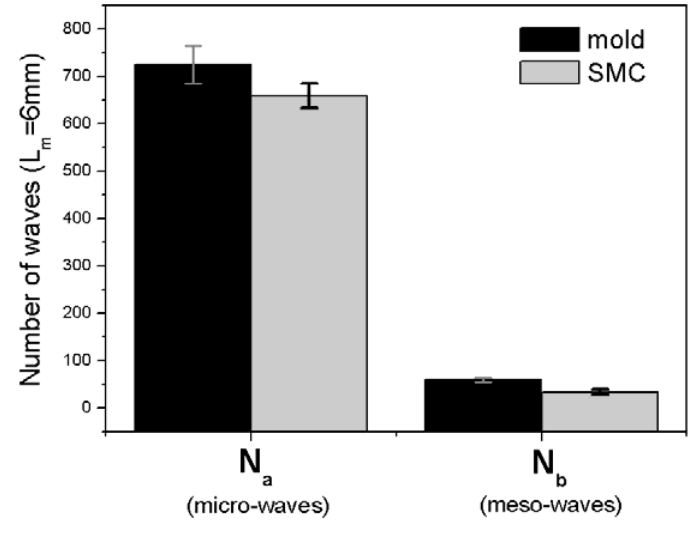
Figure 14. Meso- and micro-waves transference from mould to SMC surface.